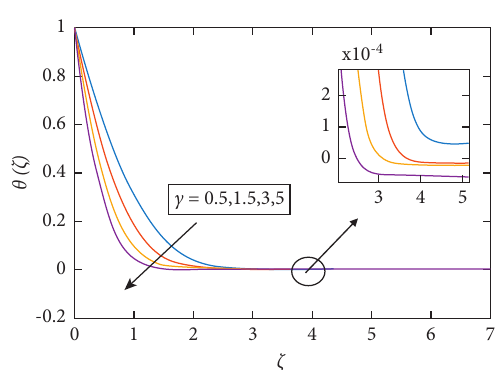
Figure 15: Pr variation on θ ( ζ ) .